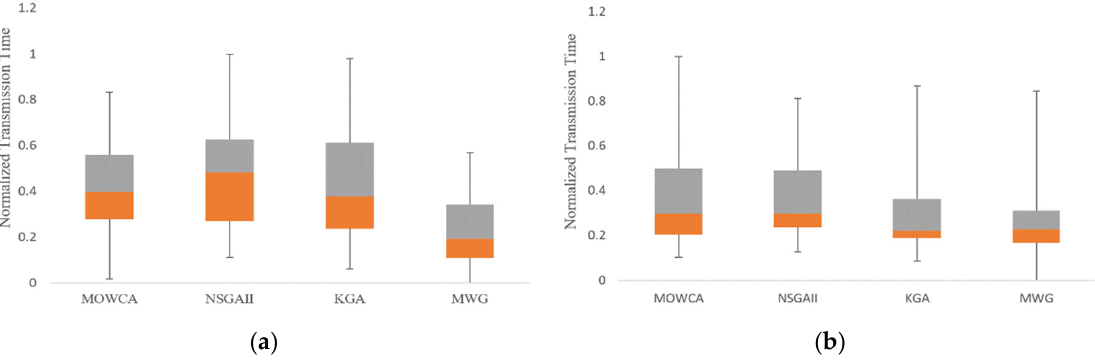
Figure 6. Comparison between algorithms due to the distribution of different solutions’ transmission time in the resulted Pareto after 100 iterations for ( a ) 100 data items and ( b ) 400 data items.